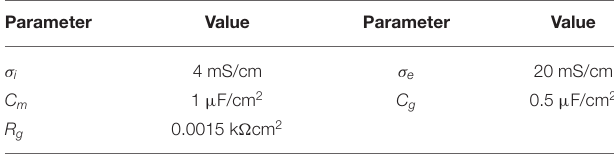
TABLE 1 | Default parameter values used in the